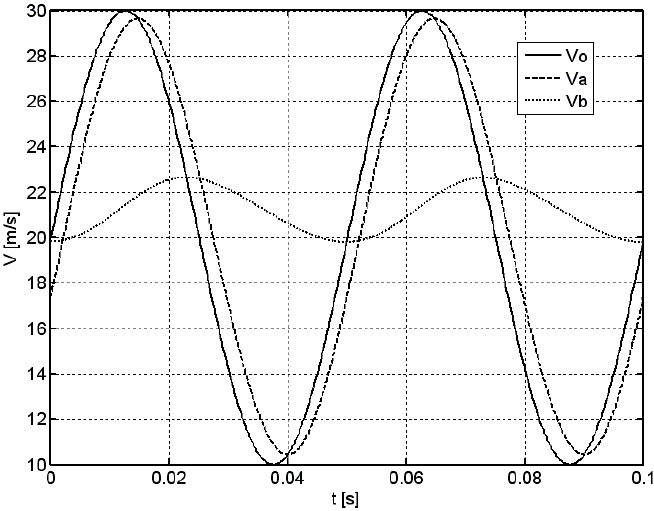
Figure 2. The time course of the response of vane anemometer with or without the optimization system to a sinusoidal excitation, v m = 20 m/s, k = 0.5, f = 20 Hz.